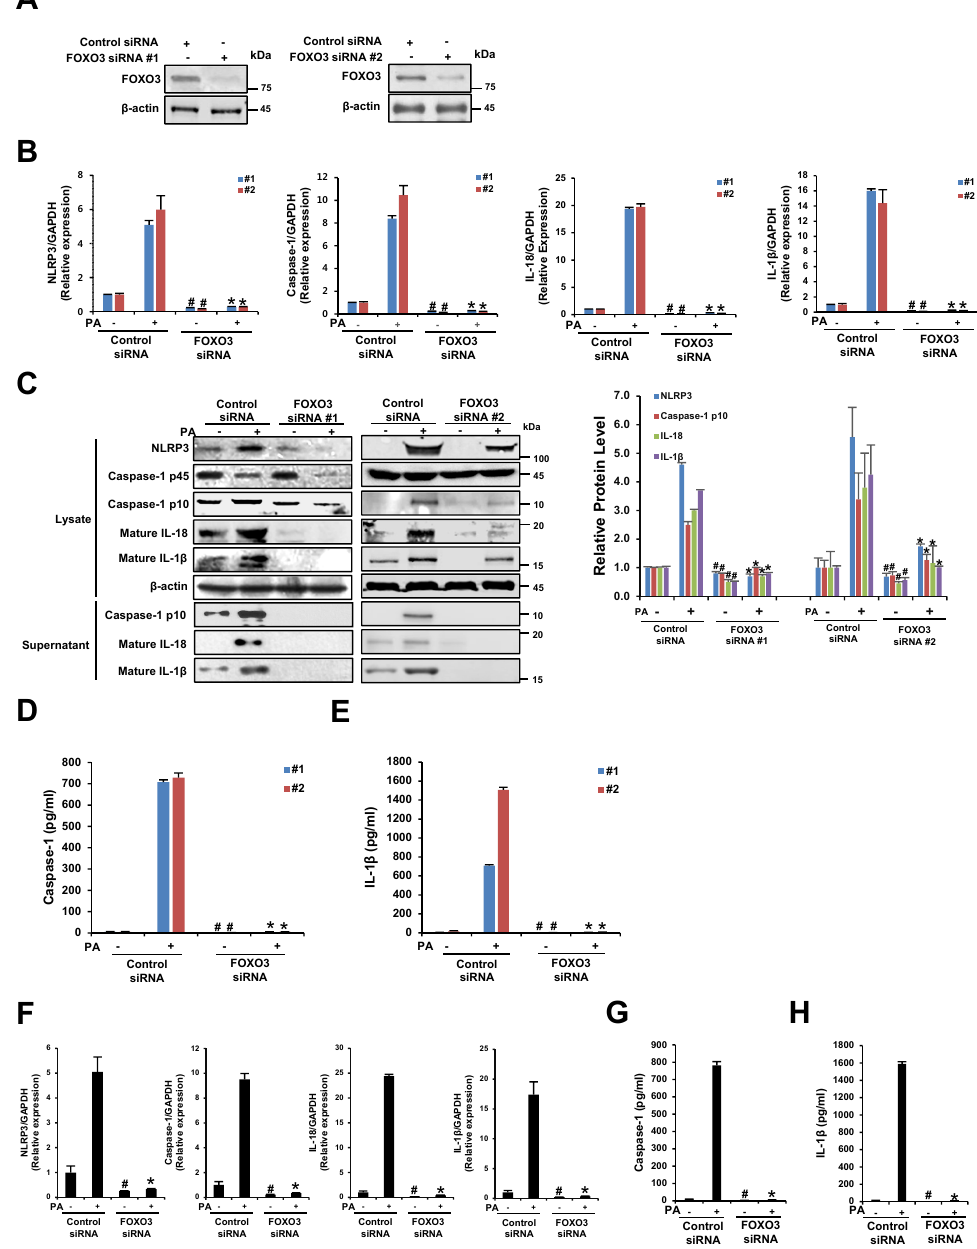
Figure 6. The silencing of FOXO3 suppresses PA-induced NLRP3 inflammasome activation. ( A – E ) THP-1 cells were transfected with 20 nM control siRNA or FOXO3 siRNA for 48 h and then treated with PA (200 µ M) for 12 h; ( A ) The FOXO3 siRNA transfection efficiency was measured by Western blot analysis; ( B ) The mRNA levels of NLRP3, caspase-1, IL-18, and IL-1 β were examined by quantitative RT-PCR; ( C ) Cell lysates and supernatants were subjected to Western blot analysis using antibodies specific for NLRP3, caspase-1, IL-18, IL-1 β , and β -actin. β -Actin was used as a loading control; ( D , E ) The levels of caspase-1 and IL-1 β in the culture supernatants were determined by ELISA; ( F – H ) Primary murine macrophages were transfected with 20 nM control siRNA or FOXO3 siRNA for 48 h and then treated with PA (200 µ M) for 12 h; ( F ) The mRNA levels of NLRP3, caspase-1, IL-18, and IL-1 β were examined by quantitative RT-PCR; ( G , H ) The levels of caspase-1 and IL-1 β in the culture supernatants were determined by ELISA. # p < 0.05 compared with the control siRNA in PA-untreated cells, and * p < 0.05 compared with the control siRNA in PA-treated